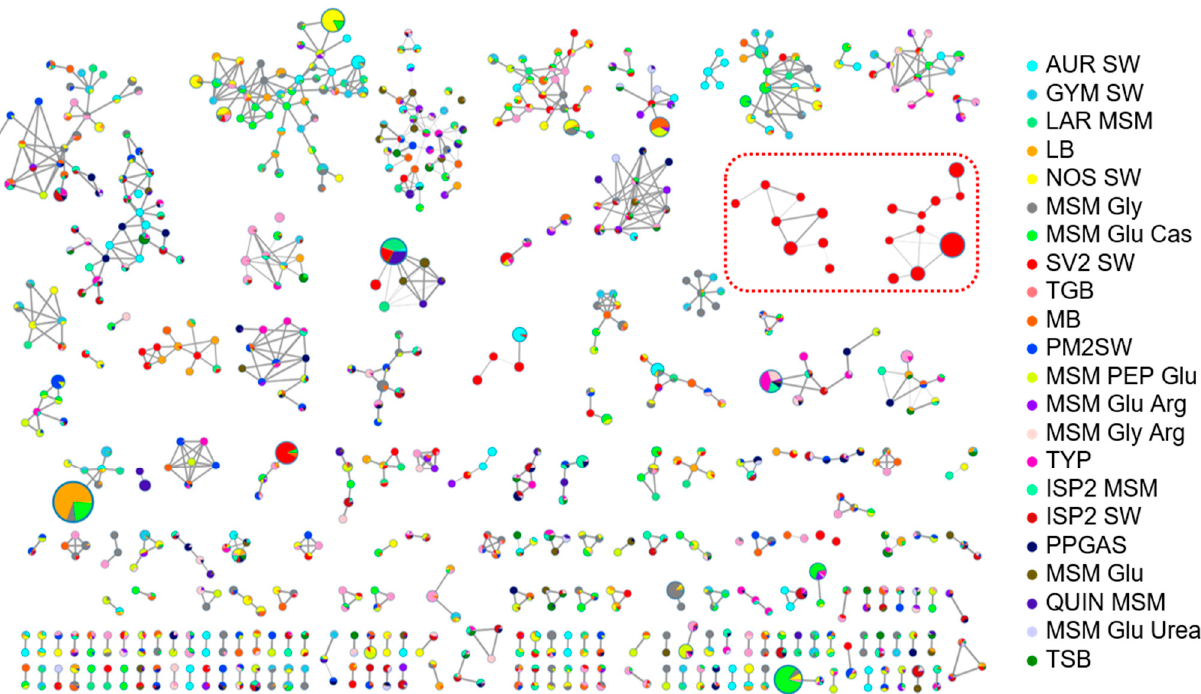
Figure 5. Molecular networking overview of crude extracts produced by Rhodococcus sp. I2R in 22 different culture media. Biosynthesis of two molecular clusters (circled in red) was triggered exclusively in the SV2 SW medium. Each color corresponds to a specific growth condition. Node size is relative to the areas of the relevant peaks in the extracted-ion chromatograms from the LC-MS run and edge thickness is relative to the cosine score similarity.